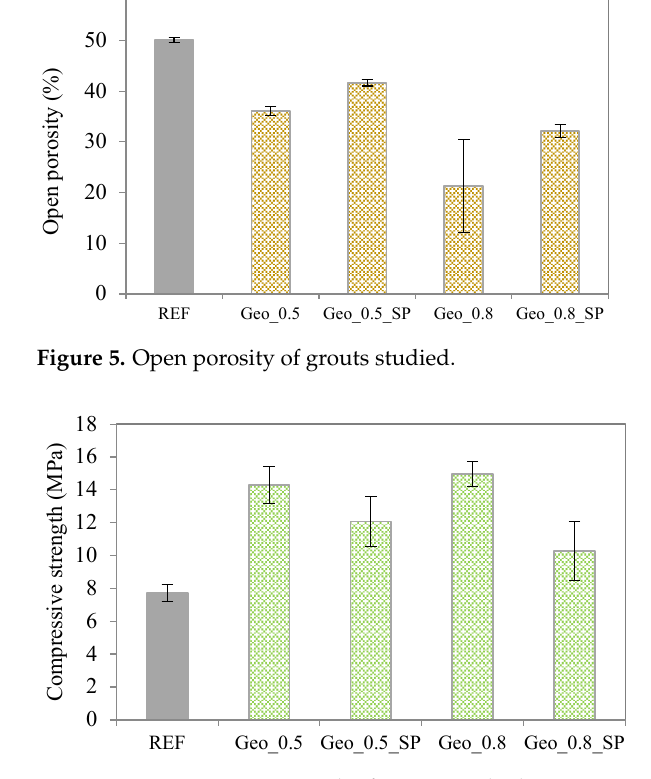
Figure 6. Compressive strength of grouts studied.